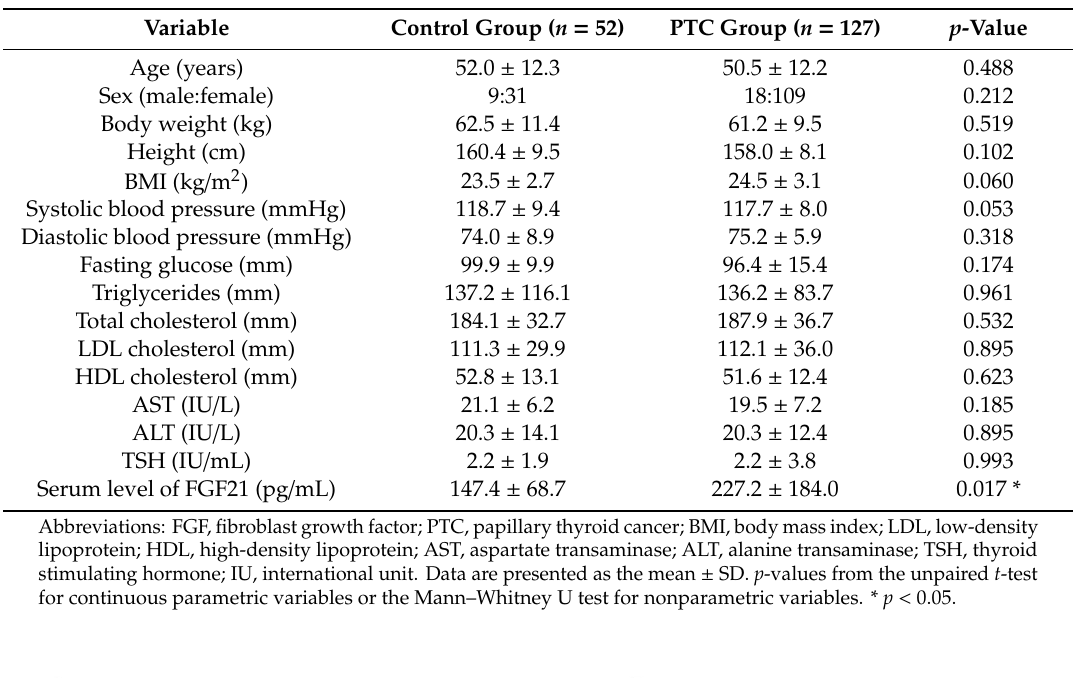
Table 1. Comparison of metabolic parameters and serum levels of fibroblast growth factor 21 (FGF21) between the control and papillary thyroid cancer (PTC) groups.